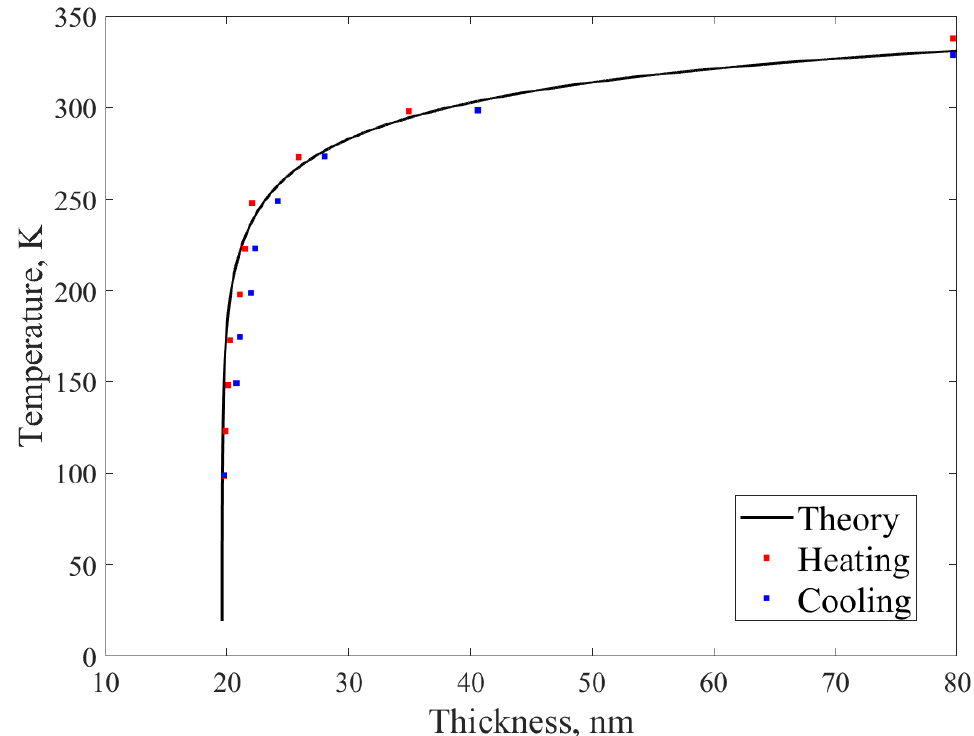
Figure 2. The Measured TiNi-wedge thickness at the transition boundary at different temperatures upon heating/cooling. T ( h ) (cid:104) T C / Ref. [49], where A, B, C, D are free parameters and T C (cid:39) 330 K (phase transition temperature for bulk